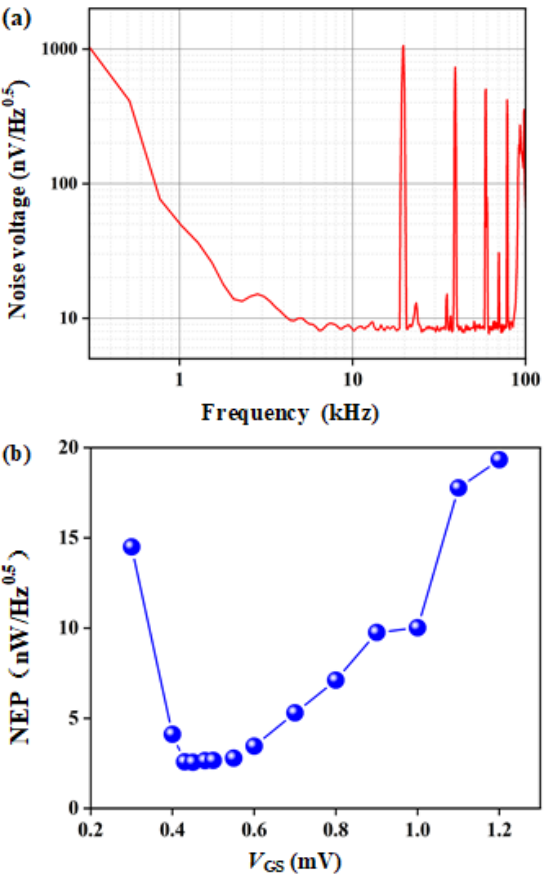
Figure 8. ( a ) Noise spectral density of the asymmetry detector at V gs = 0.43 V and V ds = 0 V; ( b ) the asymmetry detector V gs -dependence NEP at a modulation frequency of 1 kHz.